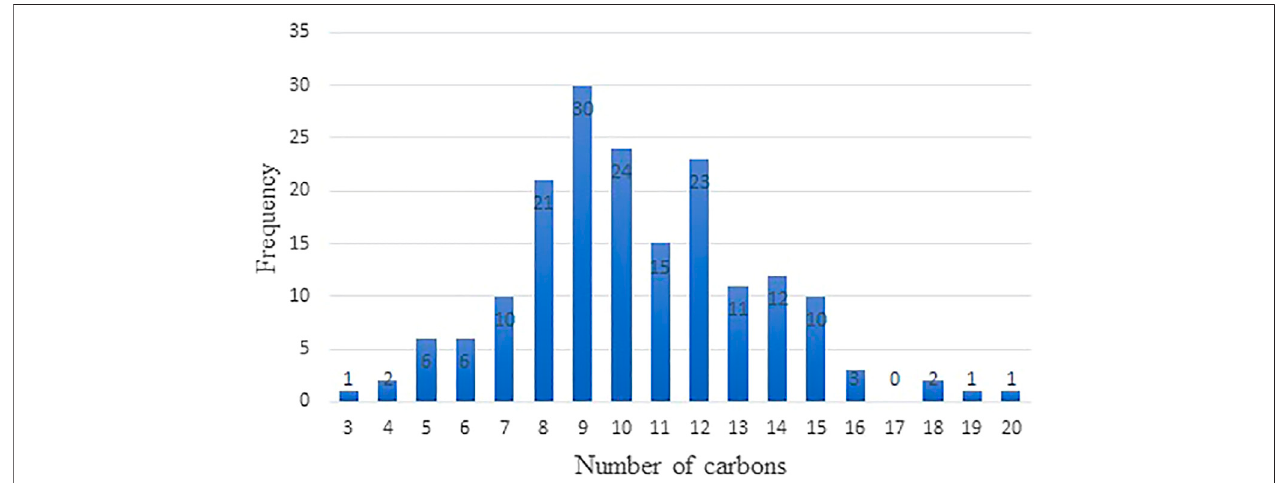
FIGURE 1 | Distribution of cycloalkanes in the database as a function of the number of carbons in the cycloalkane.